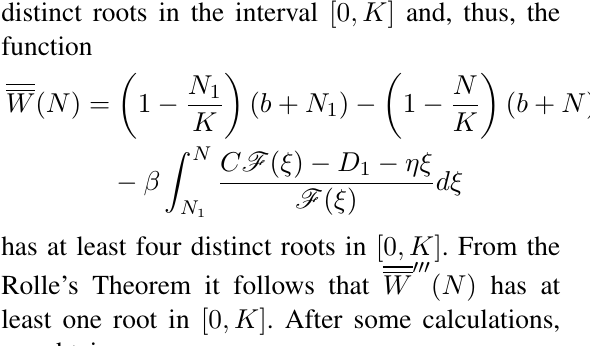
Fig. 4. Graph of f ( N ) = (1 − N/K )( b + N )